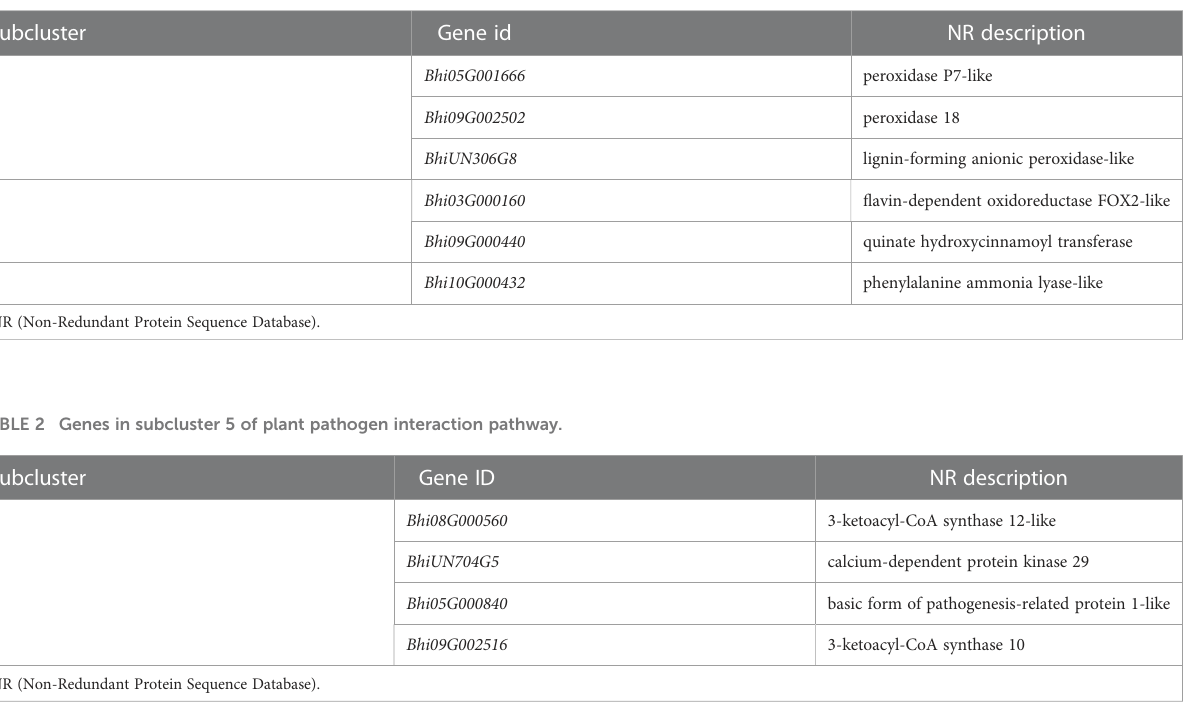
TABLE 1 Genes in subcluster 4, 5 and 6 of phenylpropanoid biosynthesis pathway.